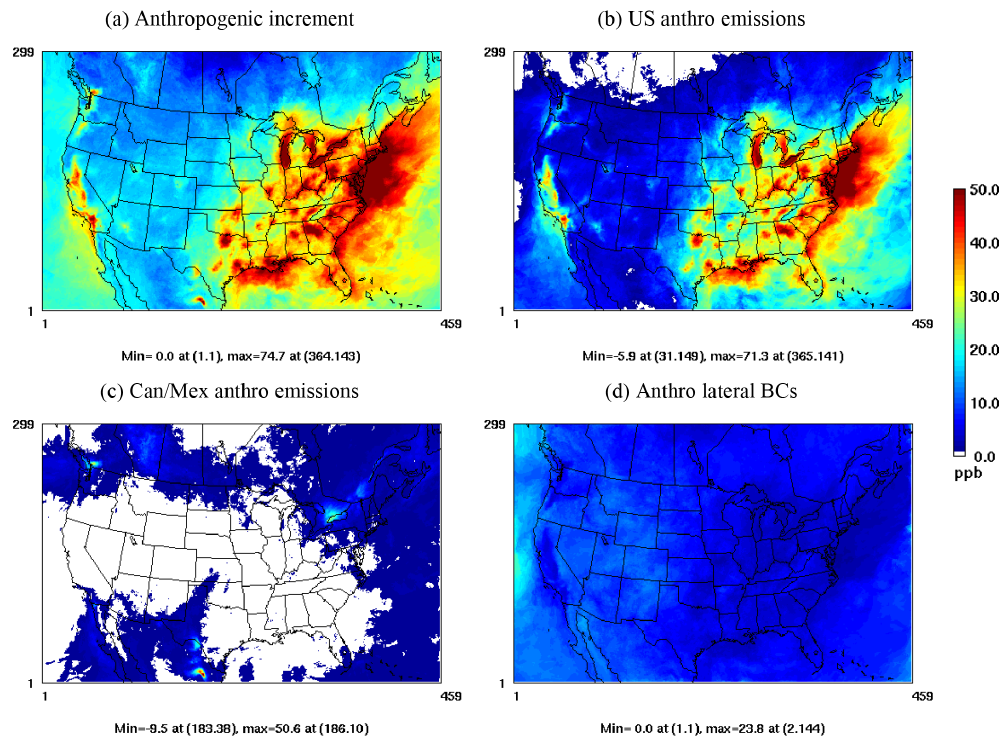
Figure 9. The anthropogenic increment (a) for the average of the top 10 MDA8 O 3 concentrations in the base case (T10base) and the contributions ( b – d ) to this increment. The contribution from the anthropogenic component of the top BCs is ≤